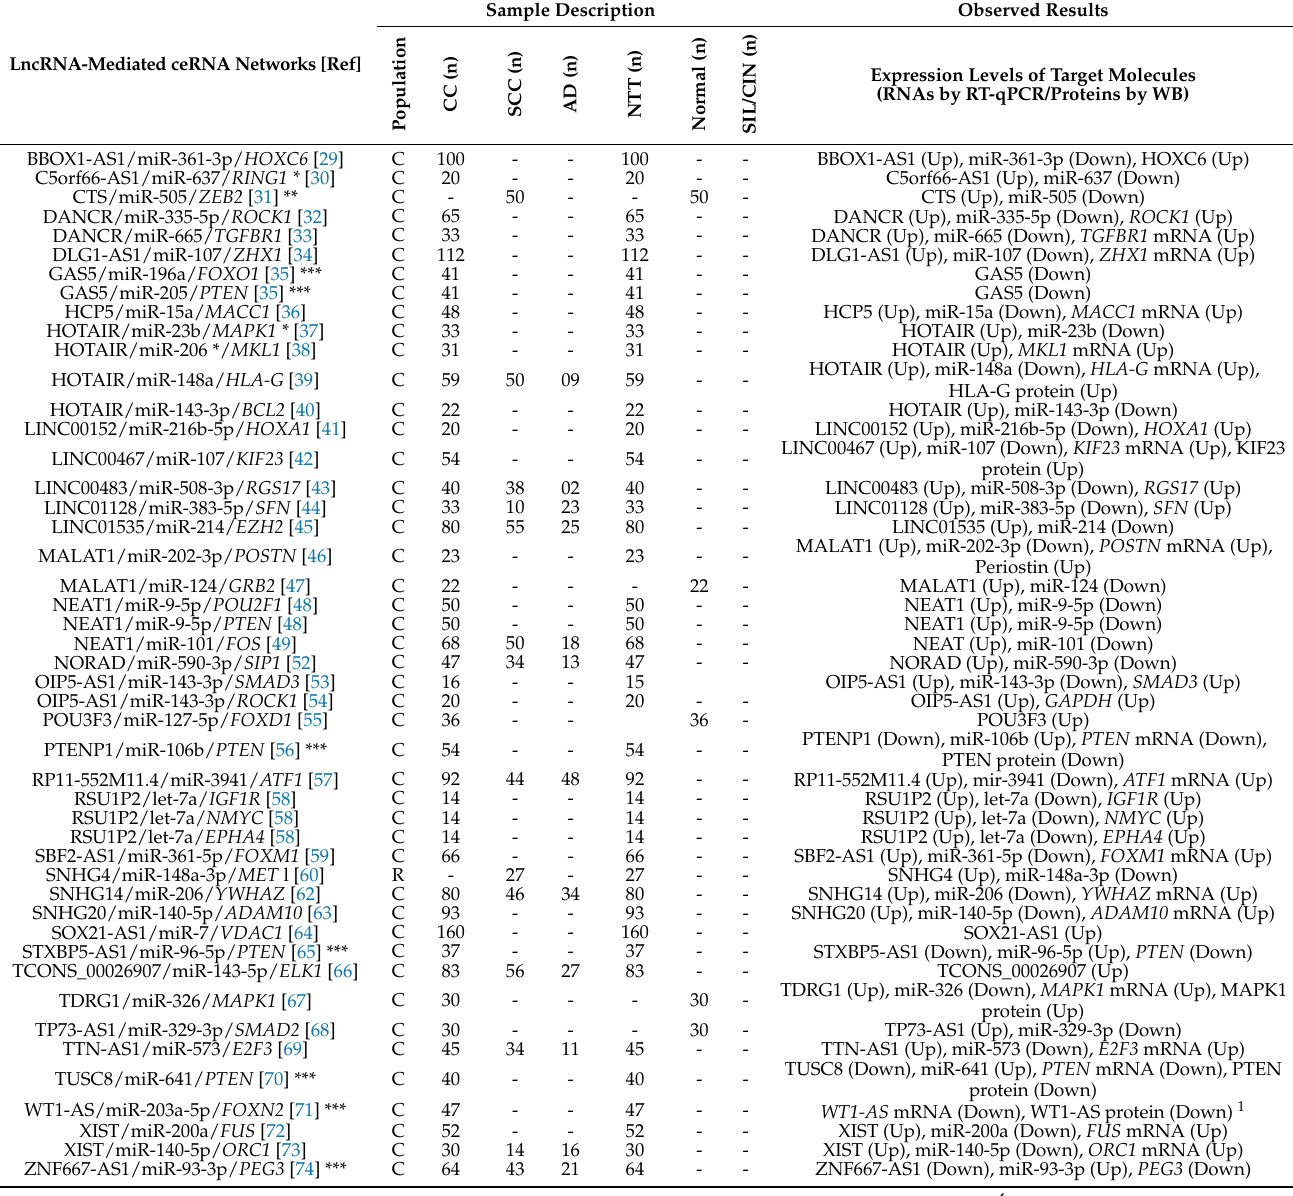
Table 3. Studies validating the involvement of the lncRNA-mediated ceRNA networks in patients with CC. Sample LncRNA-Mediated ceRNA Networks [Ref]